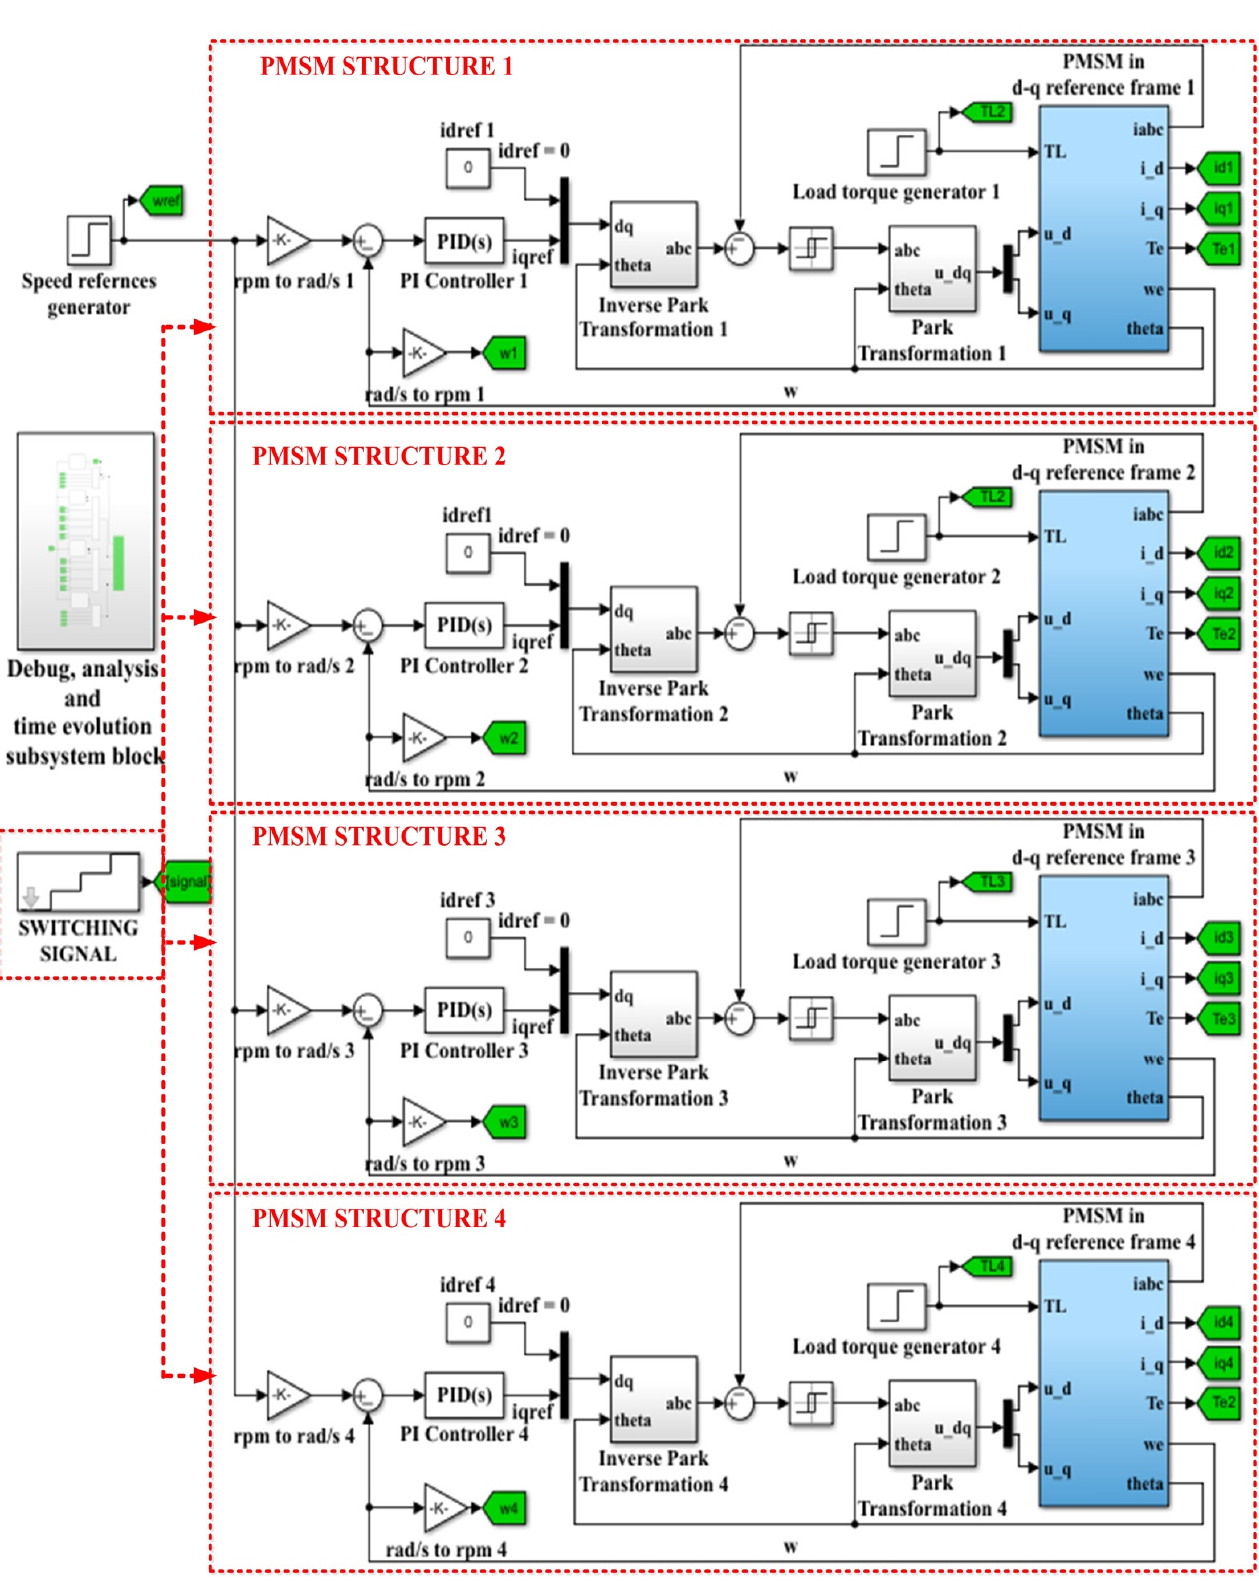
Figure 20. Simulink implementation for PMSM control system based on FOC-type strategy for PMSM variable structure with switching signal type 2.